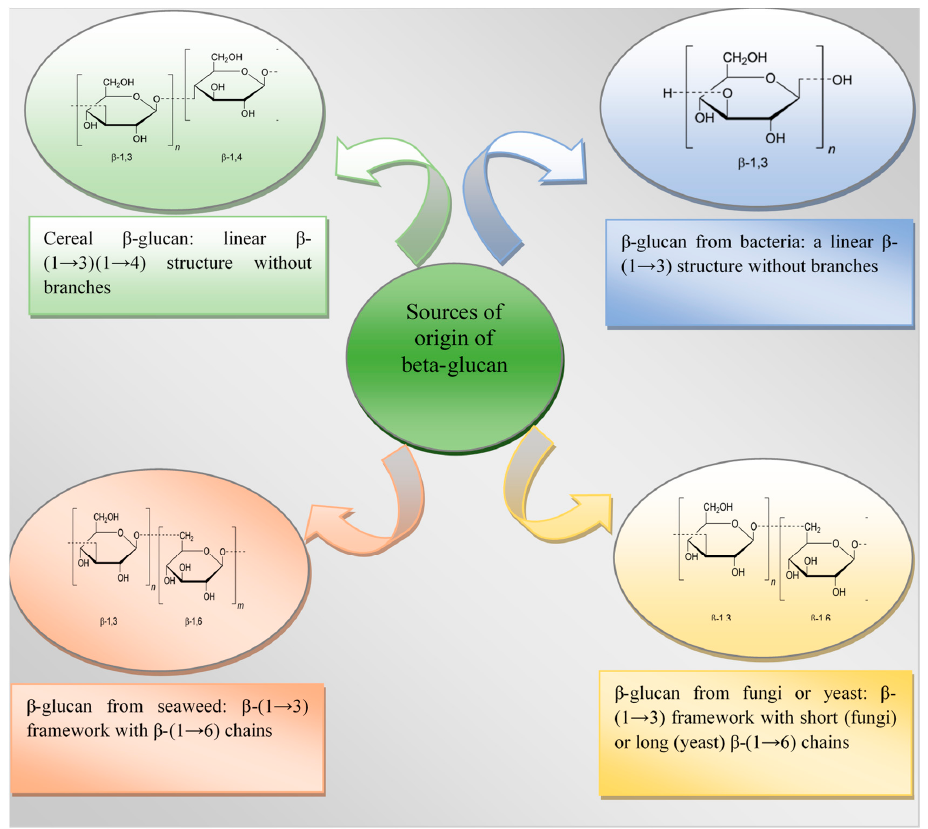
Figure 1. Chemical structure of β -glucan depending on the source of origin [59,60].